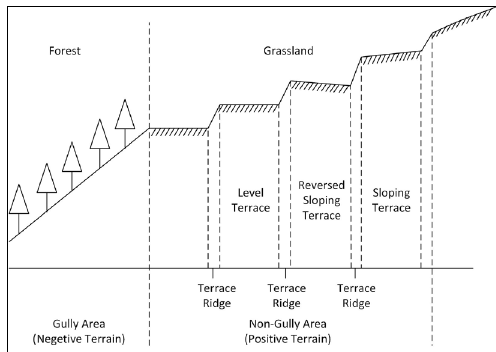
Figure 2. Illustration of the height profiles